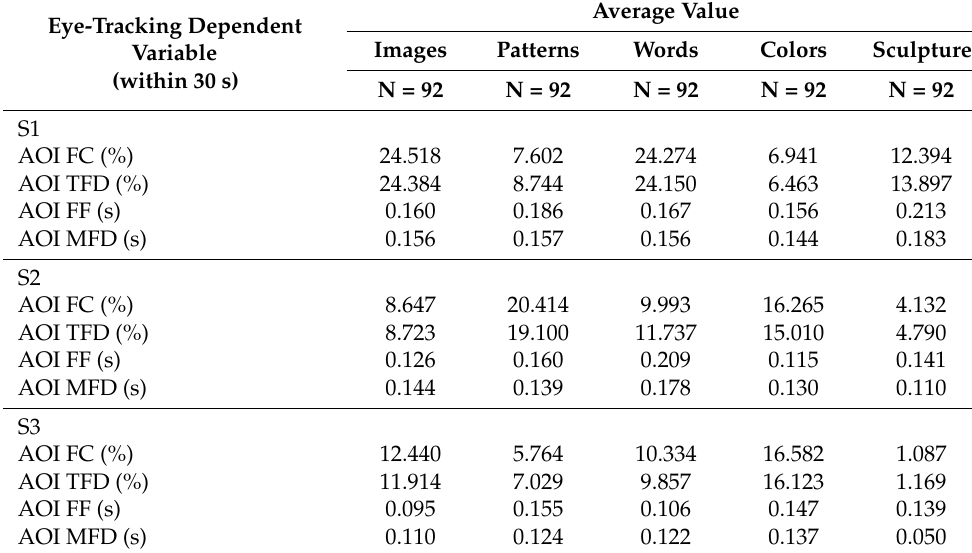
Table 12. Comparison of Eye-Tracking Index Data for Each Type of Transcribed Element. Words Eye ‐ Tracking Dependent Variable Images Patterns Words (within 30 s)